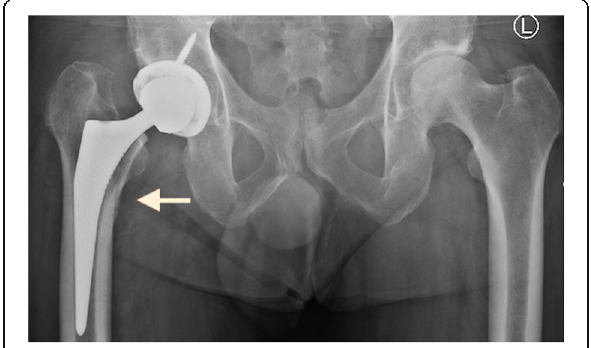
Fig. 5 X-ray of femoral fracture with subsidence of